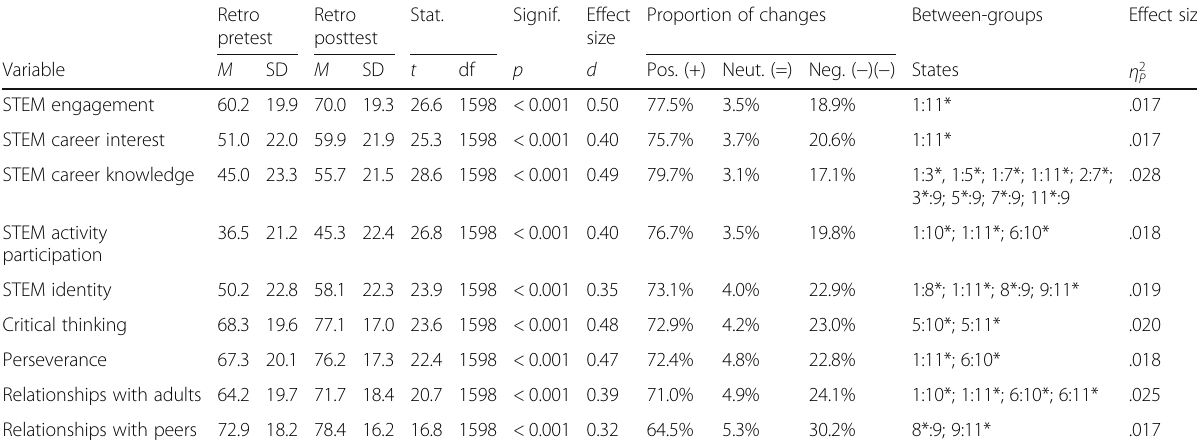
Table 4 Mean (± SD) change in retrospective pretest-posttest ratings for nine CIS-S scales with between-state comparisons Retro Retro Stat. pretest posttest